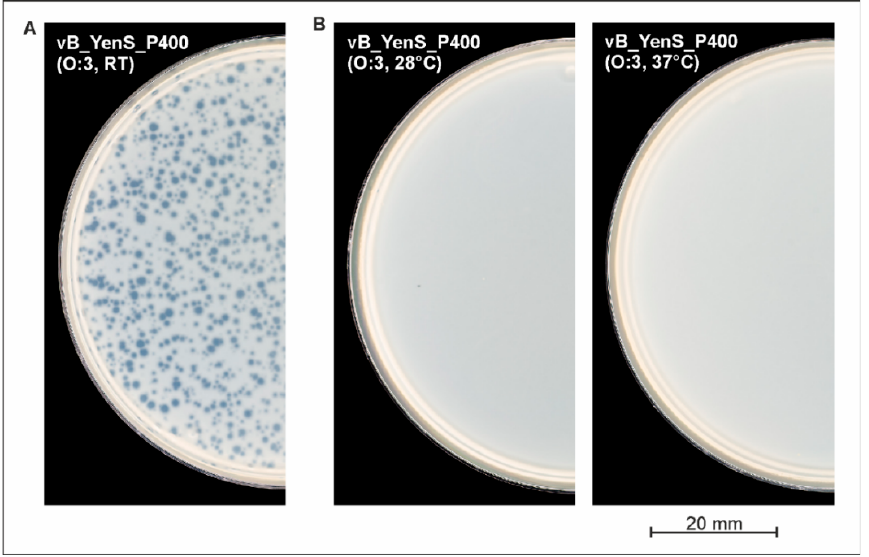
Figure 2. Plaque formation by the phage on Y. enterocolitica B4/O:3 strain DSM 9676 only occurred at room temperature ( A ), while incubation at 28 °C and 37 °C did not yield in plaques ( B ).